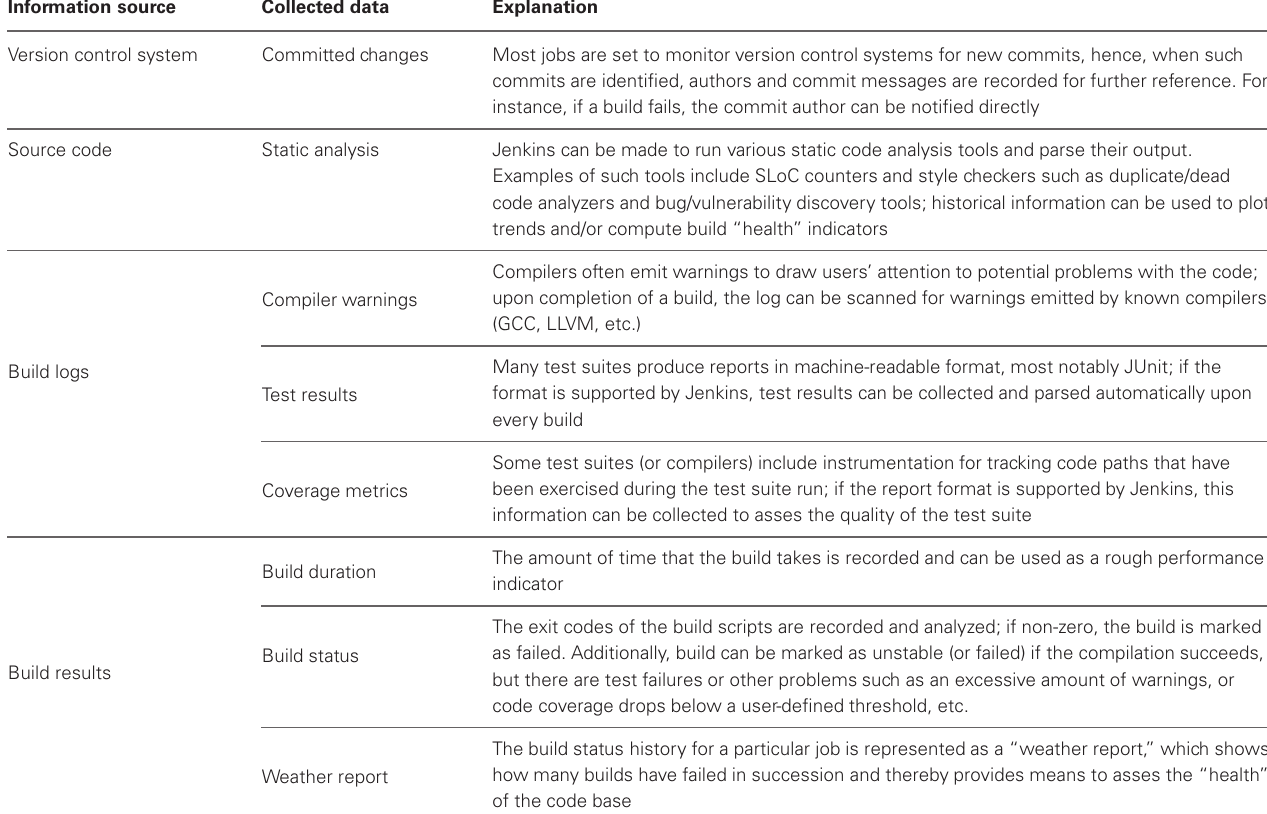
Table 1 | Summary of data collected by Jenkins build jobs and presented in the on-line web interface or stored in Jenkins home directory for further